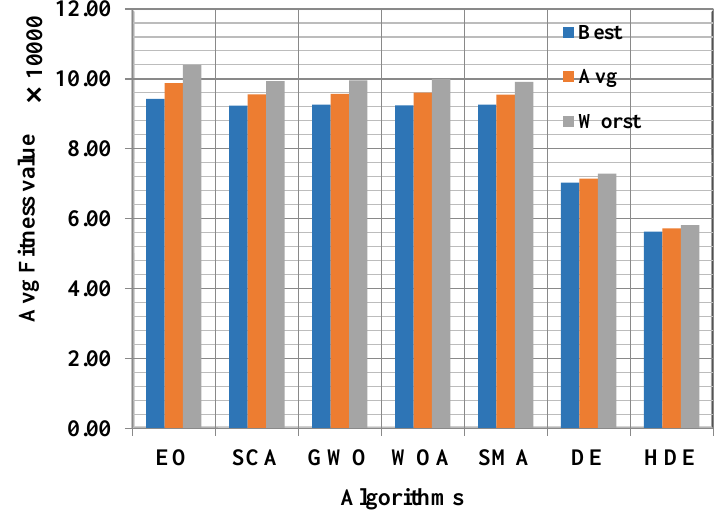
Figure 6. Comparison among algorithms by makespan.